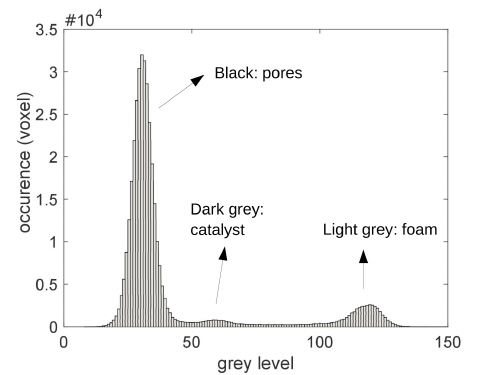
Figure 2. Example of grey levels found in coated foams (here Al